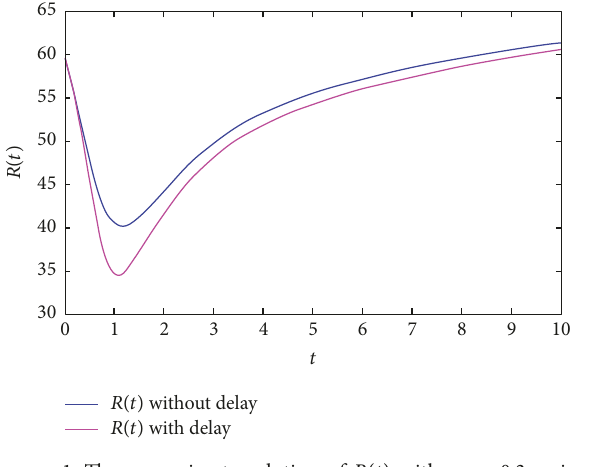
Figure 1: The approximate solution of 𝑅(𝑡) with 𝜏 = 0.3 , using dde23.